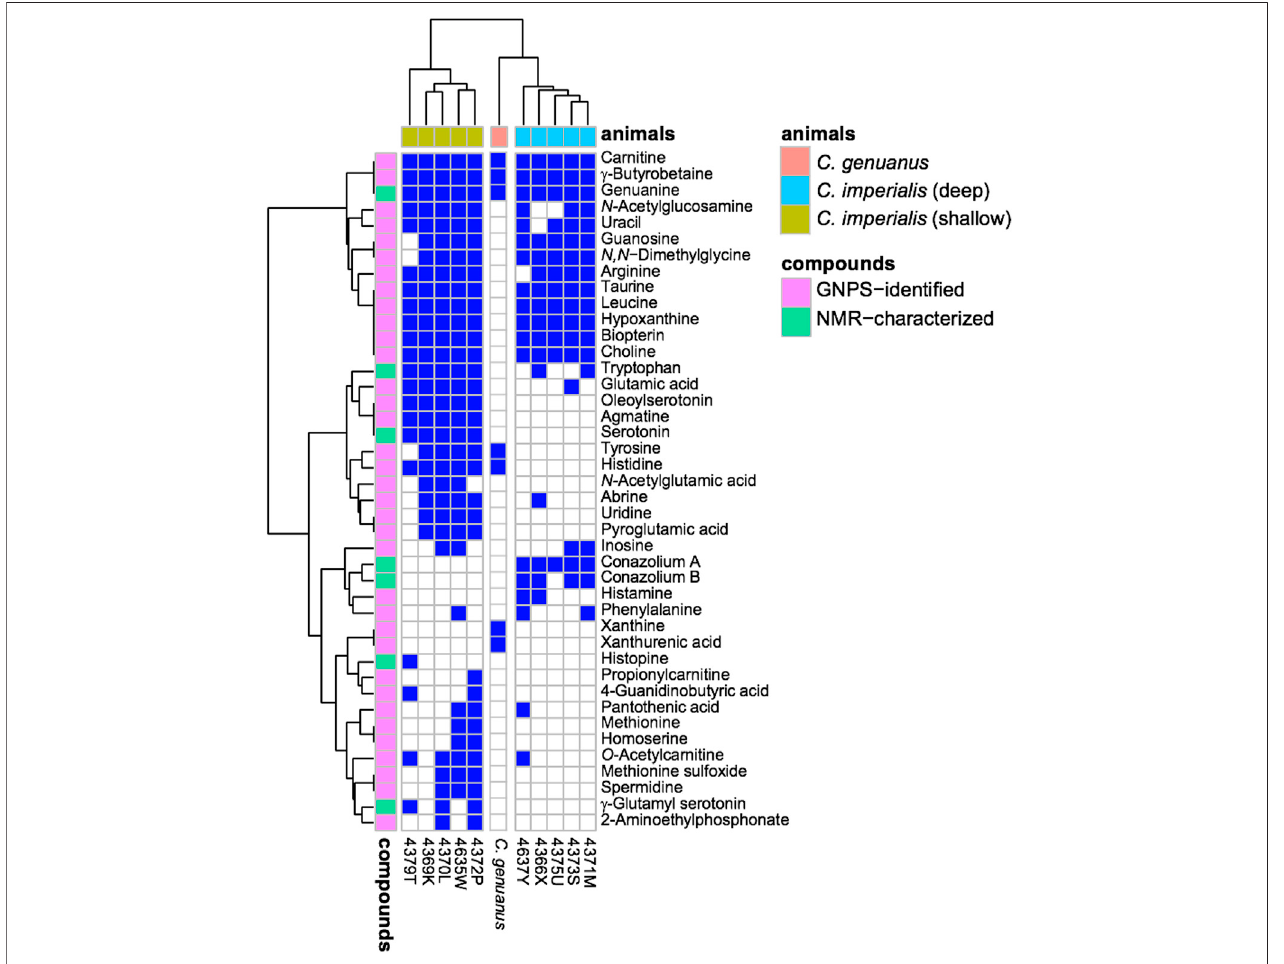
FIGURE 5 | Small molecules in Stephanoconus are highly species speci fi c. This chart indicates where each small molecule is found (blue), showing that the deep/ shallow C . imperialis species and C. genuanus contain distinctly different small molecule chemistry in their colored venom glands. GNPS: Global Natural Product Social Molecular